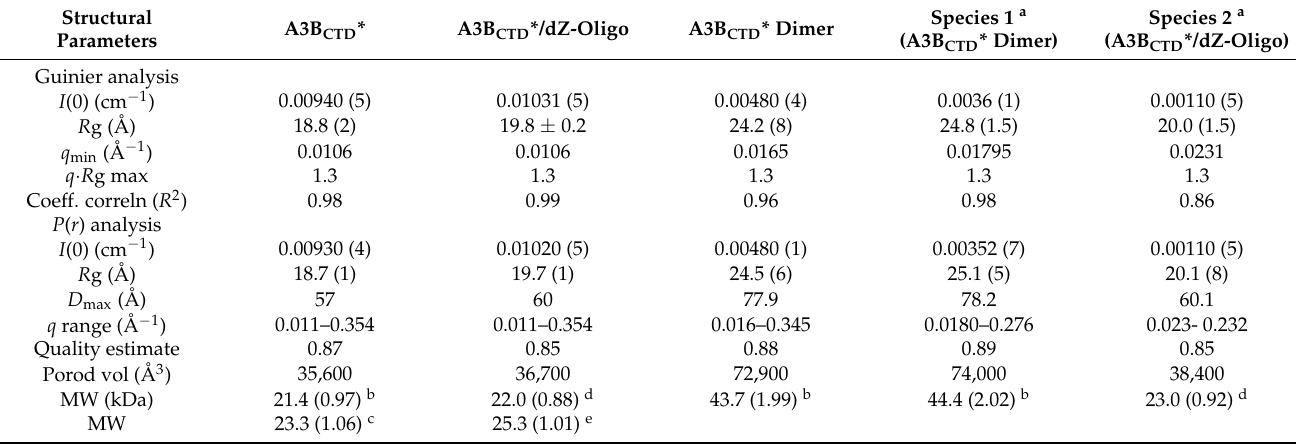
Table 1. SAXS structural parameters of the A3B CTD * and A3B CTD */dZ-oligo complex. Structural